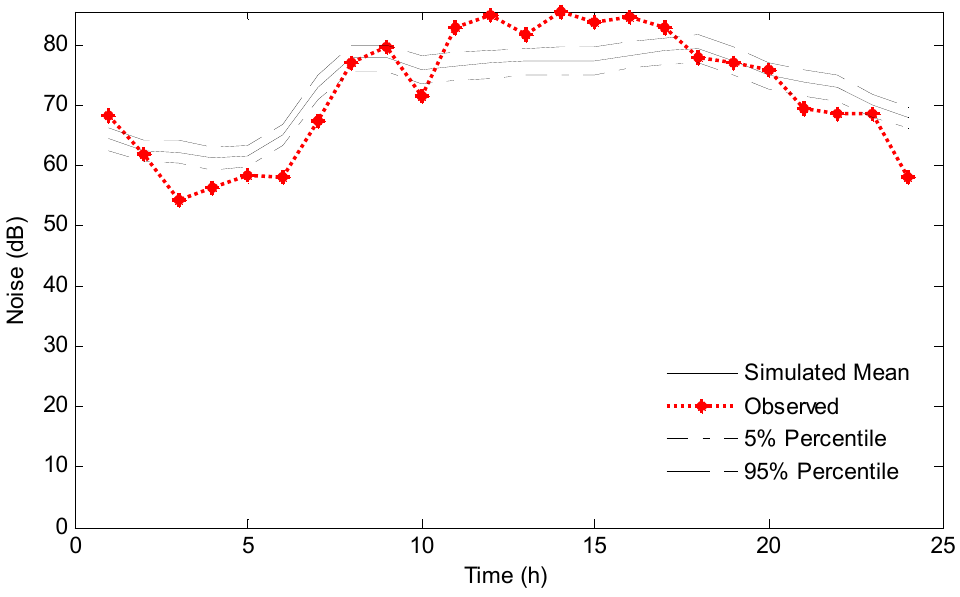
Figure 15. Comparison between the predictions and observations in scenario C.